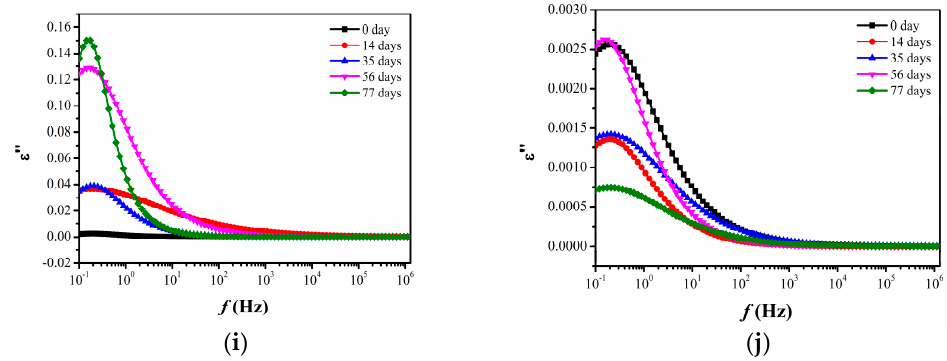
Figure 6. Permittivity of neat LDPE and nanocomposites before and after thermal aging ( a ) real permittivity of neat LDPE; ( b ) real permittivity of LDPE/SiO 2 nanocomposites; ( c ) real permittivity of LDPE/MgO nanocomposites; ( d ) imaginary permittivity of neat LDPE; ( e ) imaginary permittivity of LDPE/SiO 2 nanocomposites; ( f ) imaginary permittivity of LDPE/MgO nanocomposites; ( g ) fitting results of neat LDPE with the aging time of 77 days; ( h ) relaxation due to hopping of ions of neat LDPE; ( i ) relaxation due to hopping of ions of LDPE/SiO 2 ; ( j ) relaxation due to hopping of ions of LDPE/MgO.